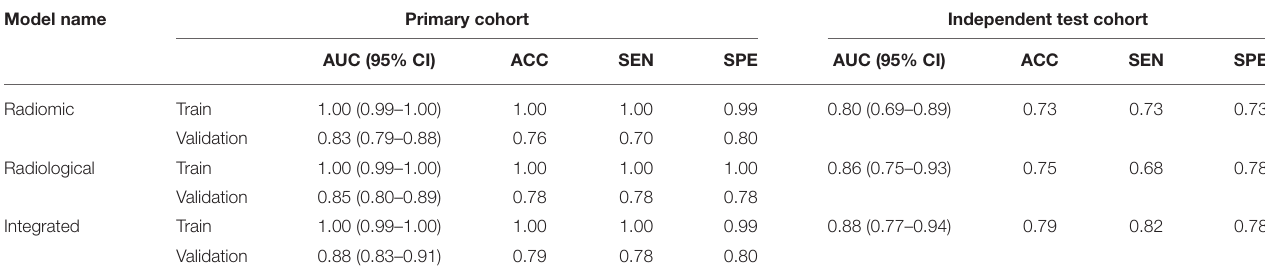
TABLE 3 | Diagnostic performance of each model in the primary cohort and test